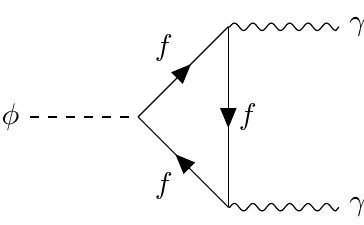
Figure 8. Feynman diagram for φ → γγ , where f = { b, t, B, T }